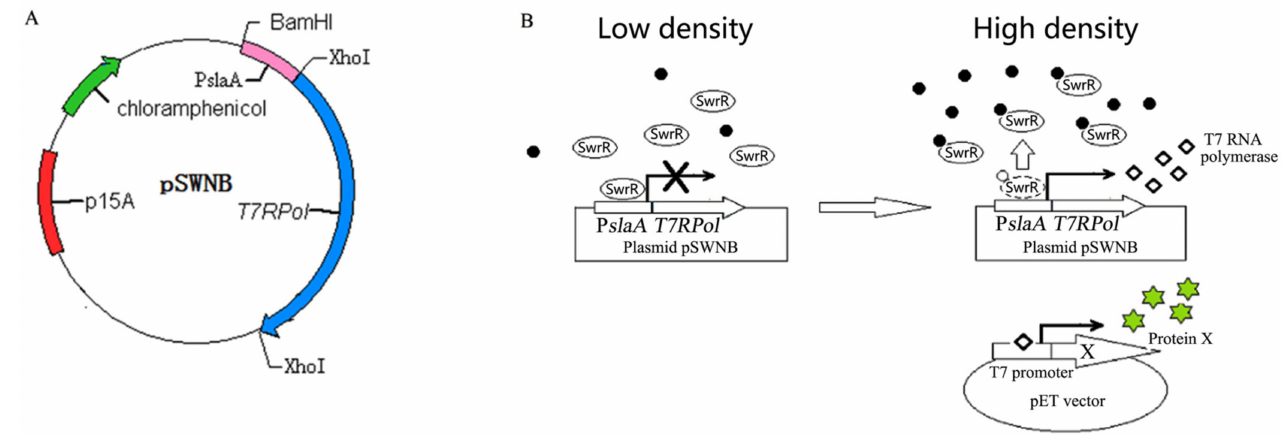
Figure 2. ( A ) Structure of the plasmid pSWNB; ( B ) the mechanism of the auto-inducing